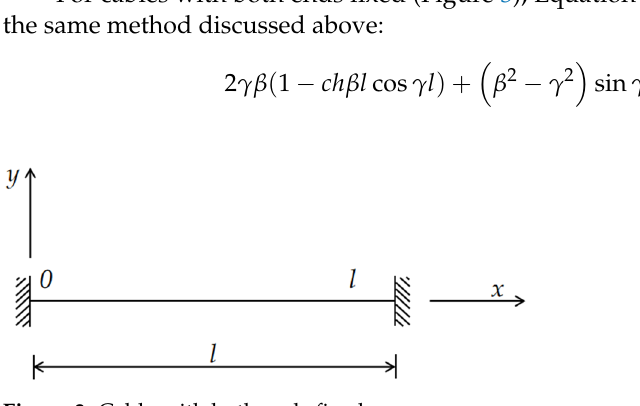
Figure 2. Cable with both ends hinged.